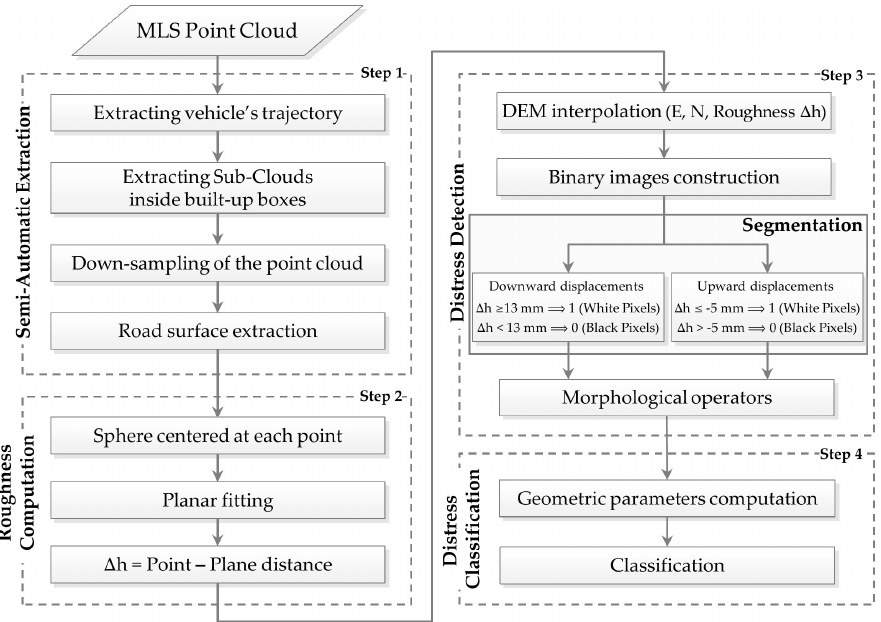
Figure 3. Data workflow.